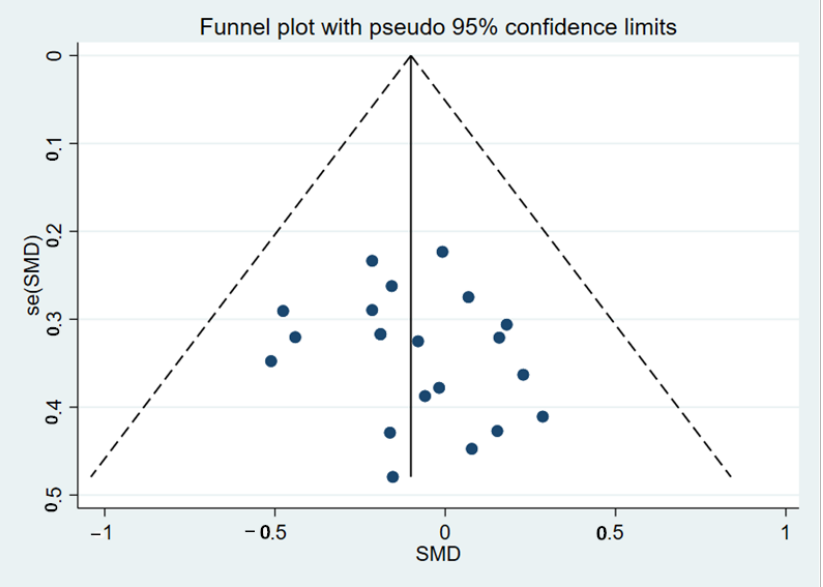
Figure 7. Funnel map of P3b latency of TD patients and HCs. SMD: Standard Mean Difference.